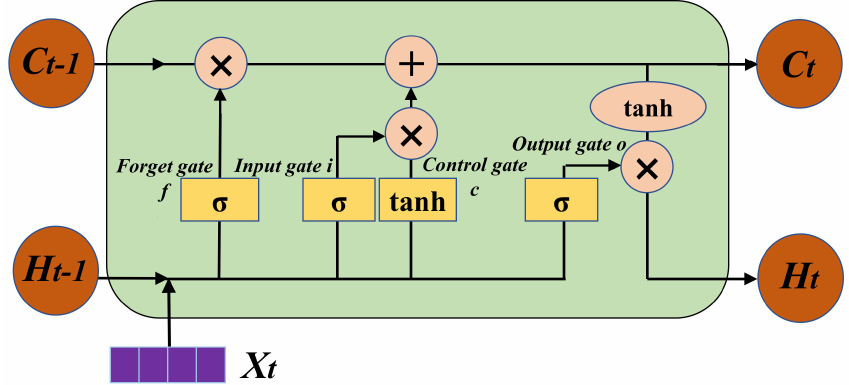
Figure 1. Structure of LSTM